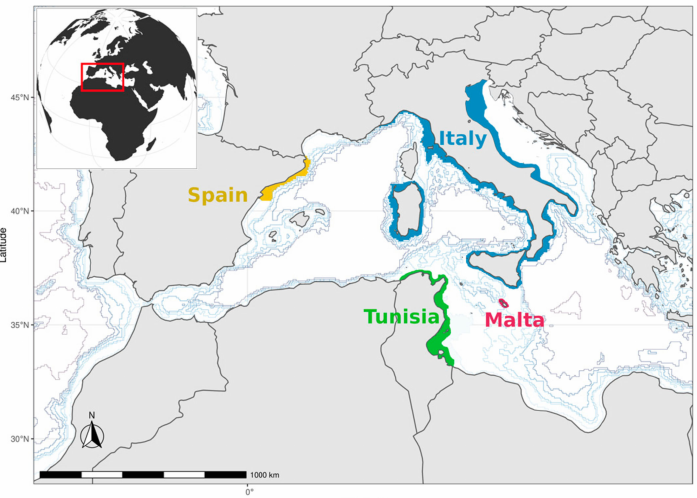
Figure 1. Map with the four countries involved in the study: Italy, Malta, Spain, and Tunisia, where the citizen science jellyfish data was